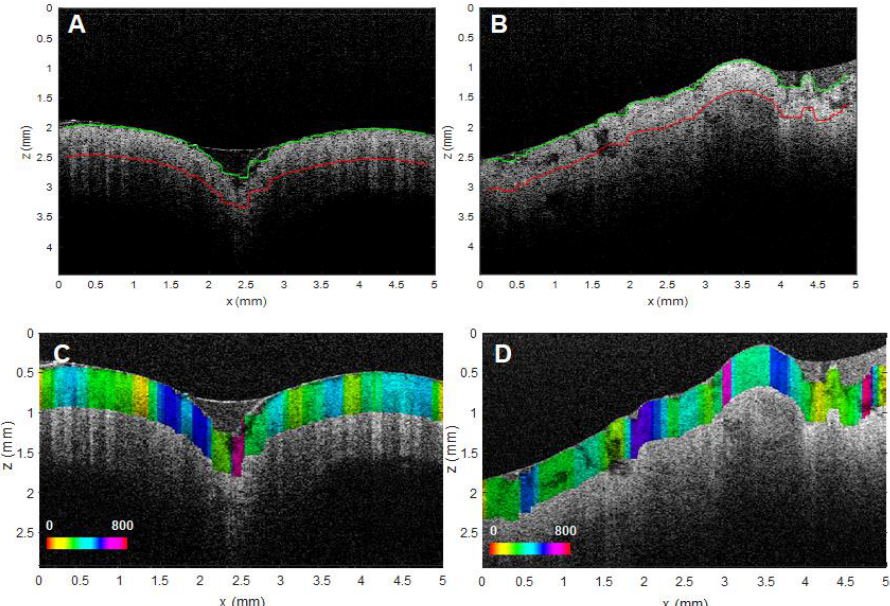
Figure 10. Normal ( A ) and abnormal ( B ) OCT images of human colon with the portion of the tissue used (green and red lines). Overlay of the images and GVD (pseudocolor hue, 0–800 fs 2 /mm) for each A-Scan normal ( C ) and adenocarcinoma ( D ) [137,139].